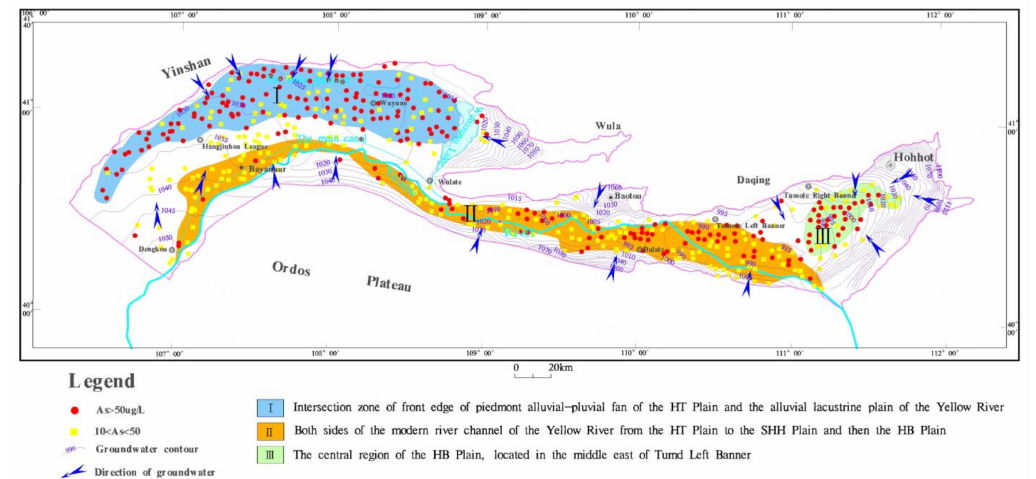
Figure 8. Contour map of groundwater table in Hetao